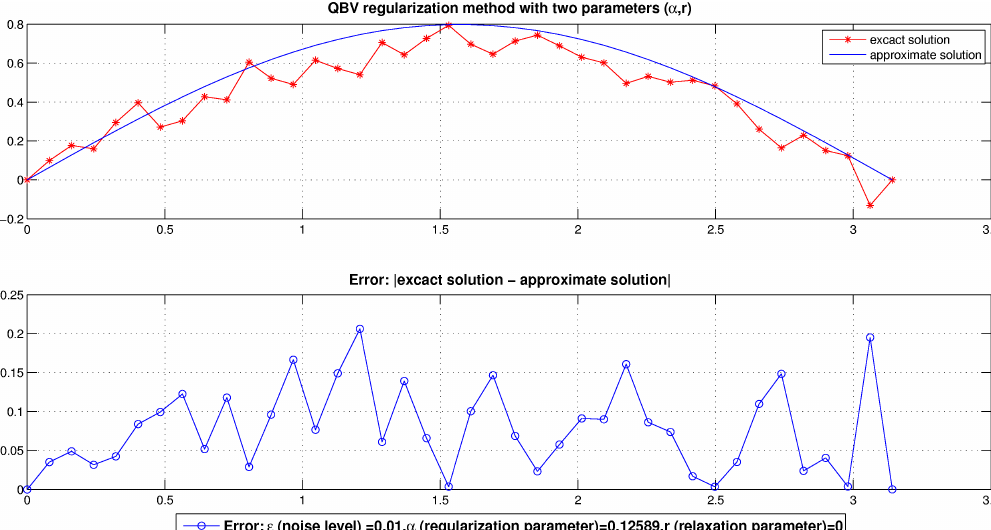
Fig. 5. ε (noise level) =0.01, α (regularization parameter)=0.025119, r (relaxation parameter)=0